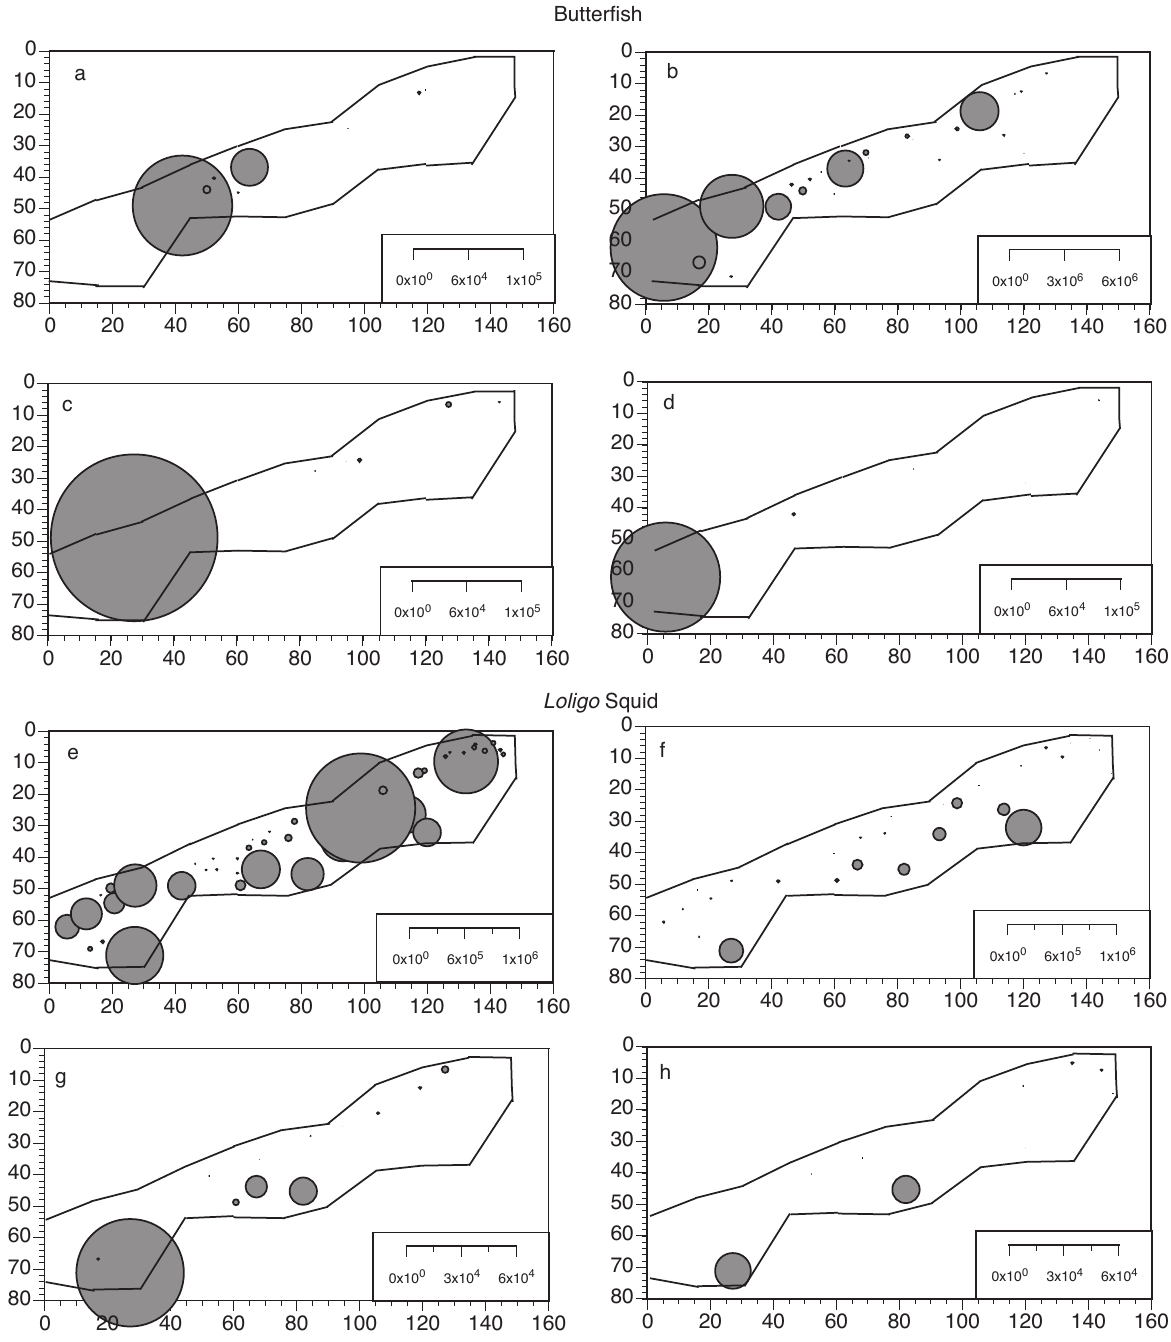
F IG . 6. – Area-weighted abundance (kg) assigned to each station occupied by the commercial vessel for butterfish for individuals: A) 7-11 cm; B) 12-15 cm; C) 16-19 cm; D) 20-22; and for Loligo squid for individuals: E) 7-12 cm; F) 13-17 cm; G) 18-22 cm; H) 23-29 cm. See Figure 5 for further